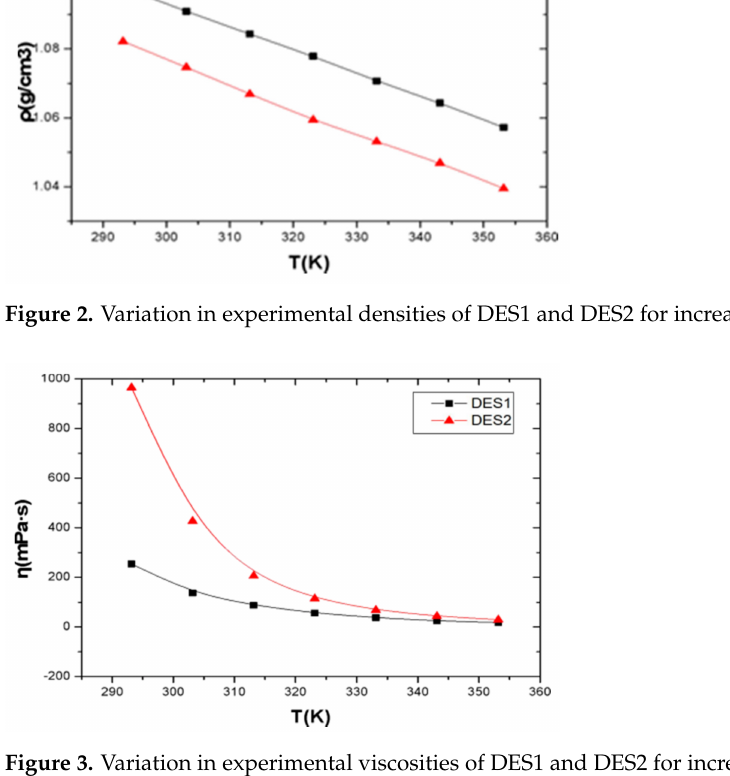
Figure 3. Variation in experimental viscosities of DES1 and DES2 for increasing